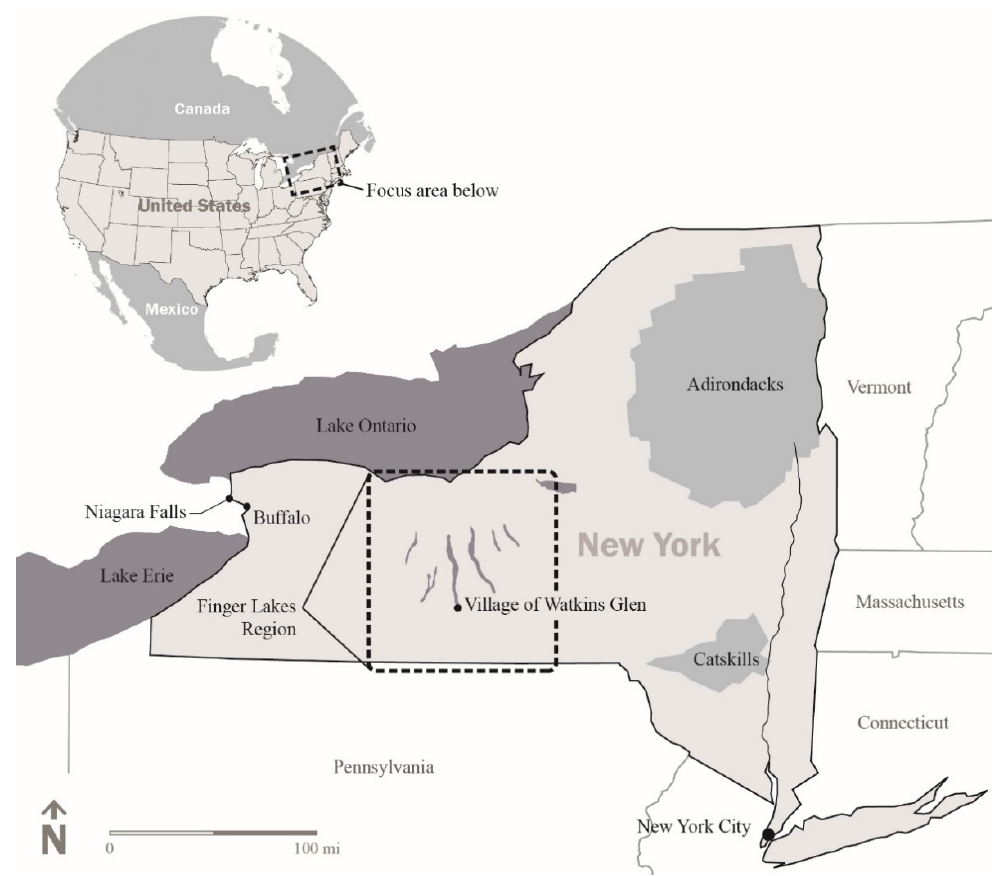
Land 2021 , 10 , x FOR PEER REVIEW